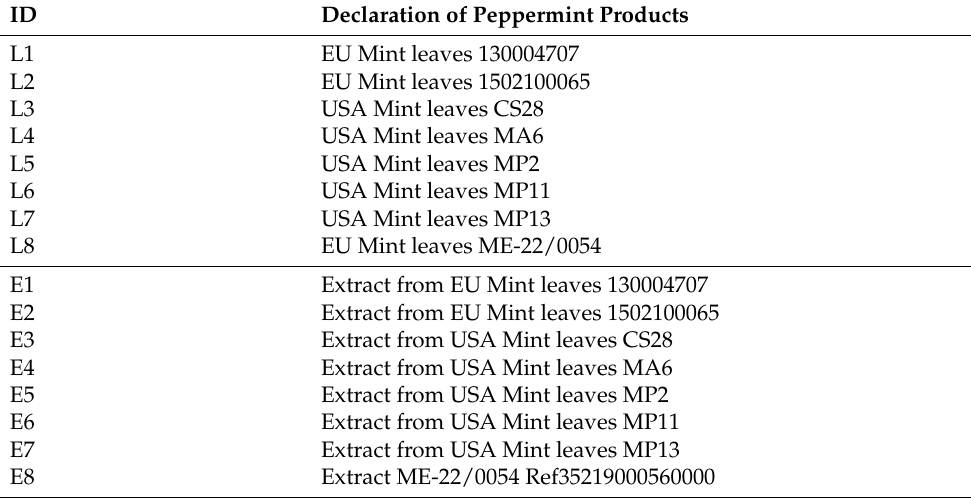
Table 1. Different peppermint products from Europe and the USA studied, i.e., the minced dried leaf samples L1–L8 and the respective powdered extract samples E1–E8 (Figure